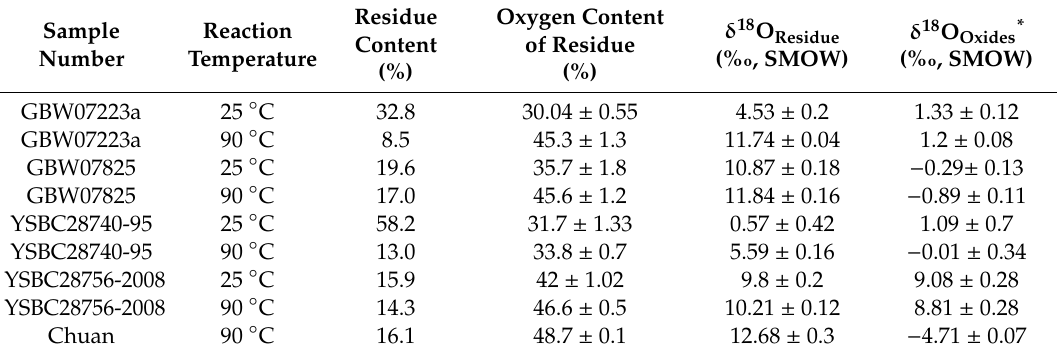
Table 1. Oxygen isotope ( δ 18 O Residue ) and oxygen content of residue after HCl dissolution treatment and oxygen isotope values of iron oxides ( δ 18 O Oxides ).